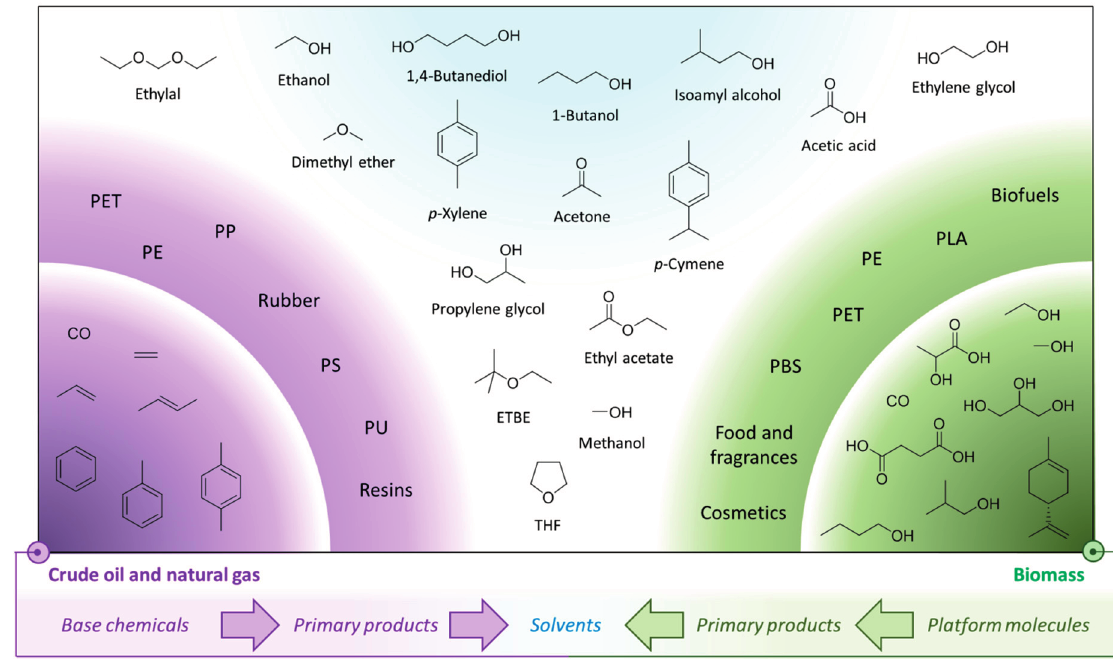
Figure 16. Solvents common to the petrochemical industry and the emerging bio-based